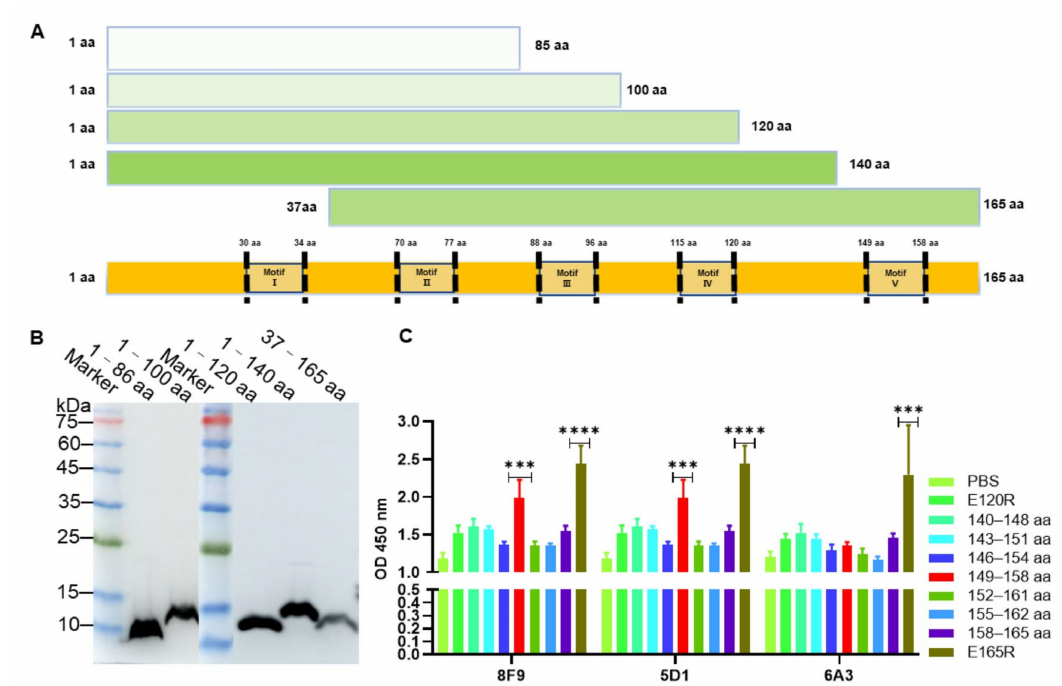
Figure 3. Expression of truncated recombinant proteins of ASFV dUTPase (E165R) and epitope identification of monoclonal antibody. ( A ) Schematic diagram showing the length and amino acid positions of truncated recombinant E165R proteins. ( B ) Identification of truncated recombinant E165R proteins using mAb against His-tag by Western blotting. ( C ) Identification of monoclonal antibody recognition epitopes by ELISA. Note: “***” means the difference is significant at the 0.001 level and “****” means the difference is significant at the 0.0001